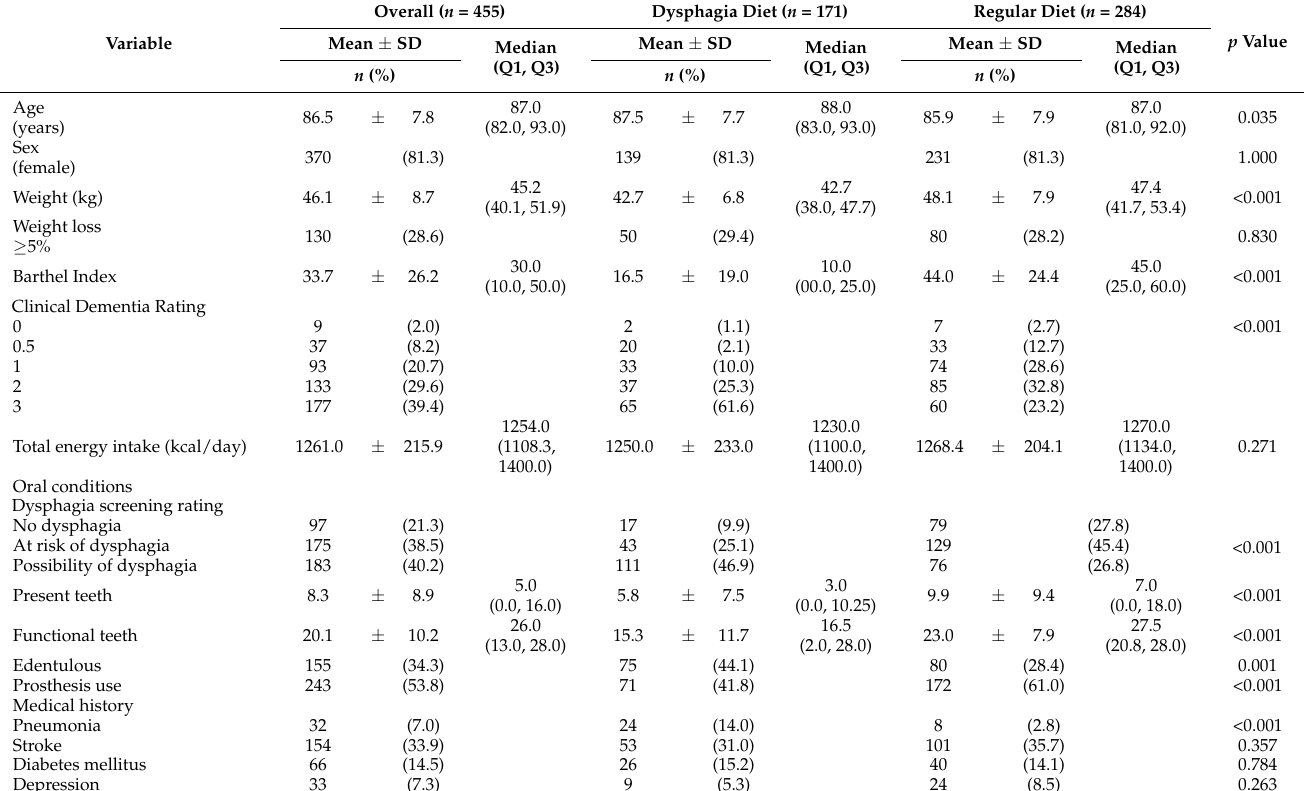
Table 1. Characteristics of study participants and comparison between the regular and dysphagia diet groups at